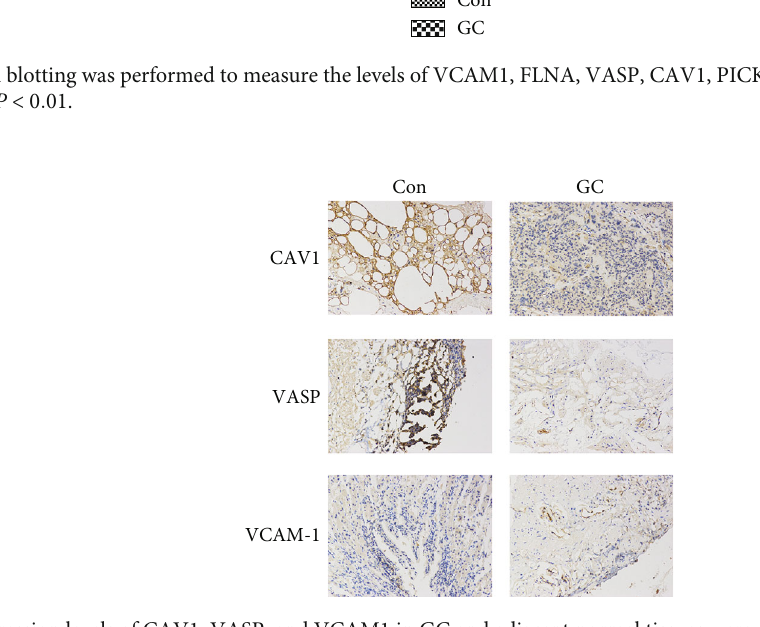
Figure 5: The expression levels of CAV1, VASP, and VCAM1 in GC and adjacent normal tissues were veri fi ed by IHC assays. ∗∗∗ P < 0 : 001 .